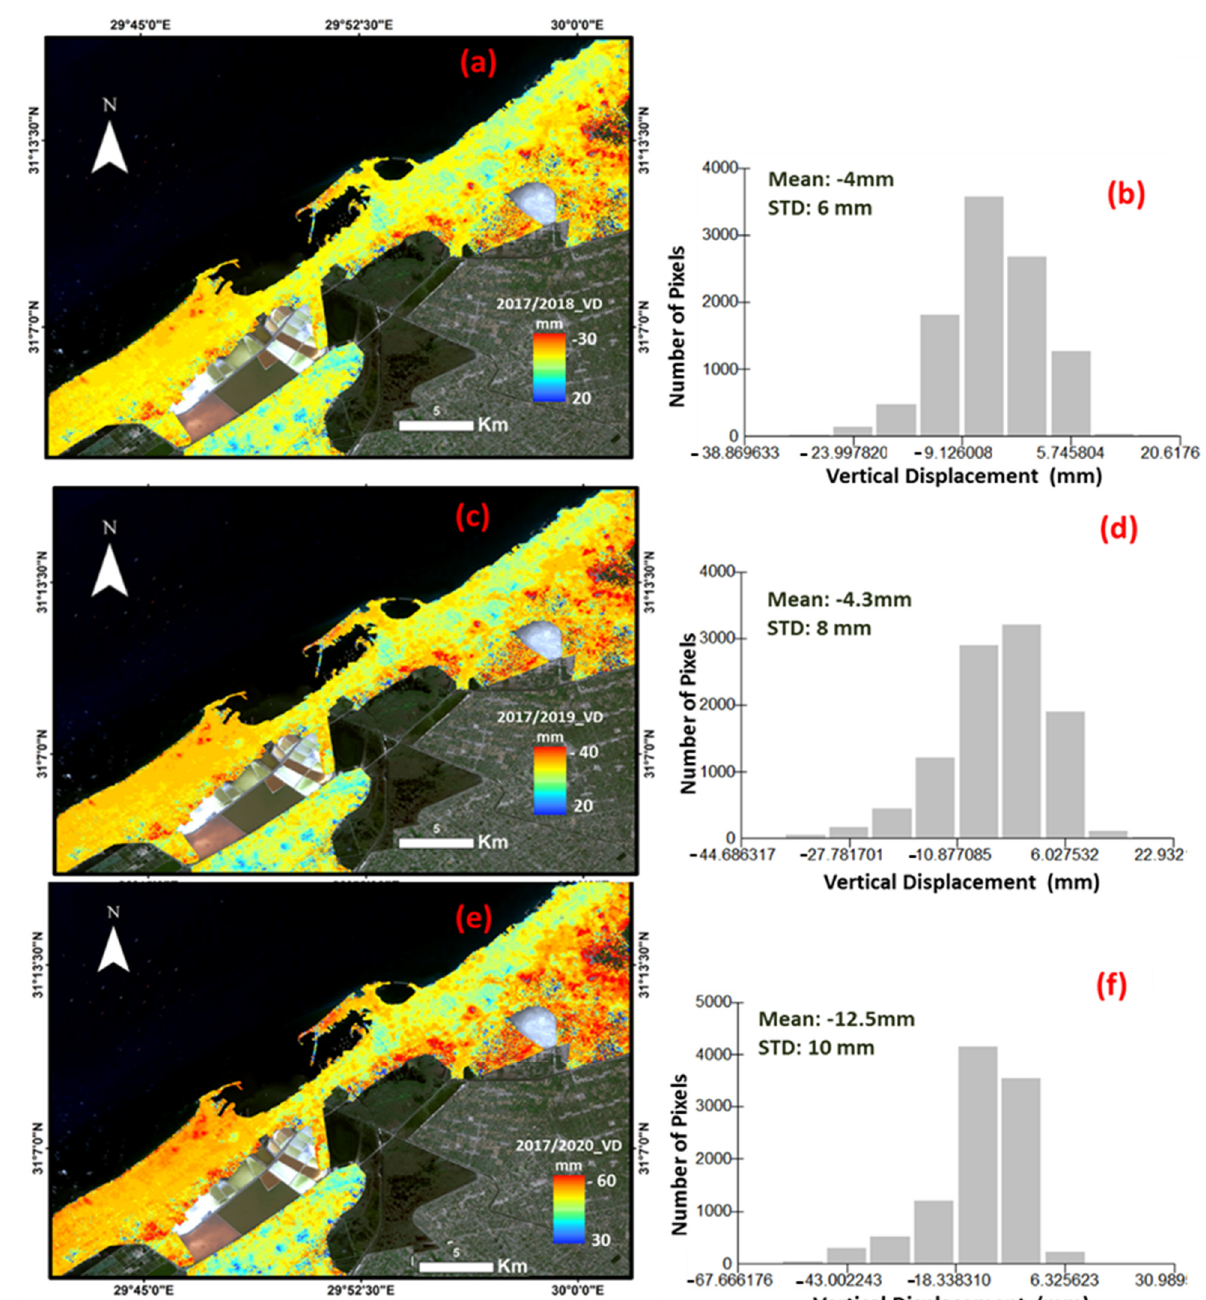
Figure 13. Vertical displacement of Alexandria City from: ( a ) 2017/2018; ( c ) 2017/2019; ( e ) 2017/2020 and the corresponding histograms of each period ( b , d , f ).